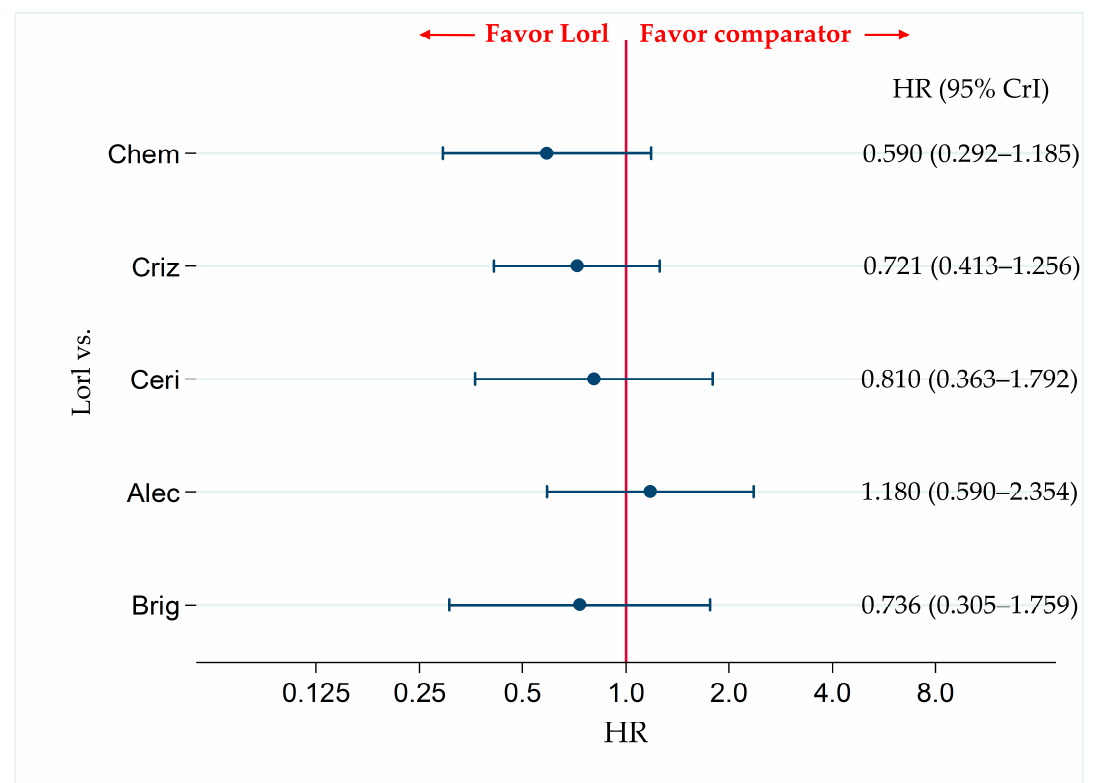
Figure 7. Comparative efficacy of lorlatinib and the existing therapeutic agents in terms of OS in patients with ALK-p ALK-inhibitor-naïve NSCLC. A comparison of OS in ALK-p ALK-inhibitor-naïve advanced NSCLC patients treated with lorlatinib and each of the other five therapeutic agents including chemotherapy, crizotinib, ceritinib, alectinib, and brigatinib as comparator is presented. Comparisons are expressed as lorlatinib versus each of the comparator agents. Data are expressed as hazard ratios (HRs) and 95% credible intervals (CrIs). OS, overall survival; ALK, anaplastic lymphoma kinase; ALK-p, anaplastic lymphoma kinase-positive; NSCLC, non-small cell lung cancer; Lorl, lorlatinib; Brig, brigatinib; Alec, alectinib; Ceri, ceritinib; Criz, crizotinib; Chem, chemotherapy.